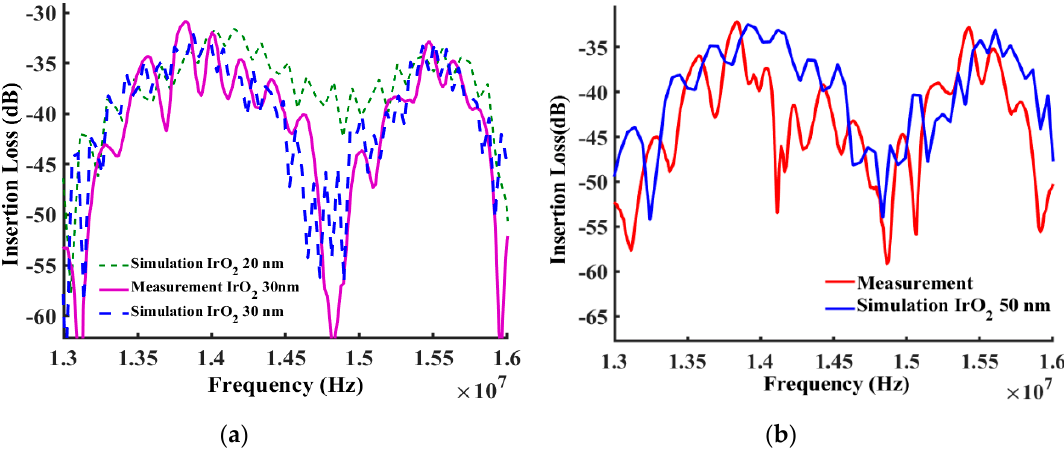
Figure 6. ( a ) Comparison between simulated and measured frequency responses for the device (with 100 nm Cr IDTs, a 500 nm-thick ZnO layer, and an IrO 2 layer of 30 nm) from 13 MHz to 16 MHz. The experimental results are obtained from the device with Cr IDTs, a 500 nm-thick ZnO layer, and a 30 nm-thick IrO 2 layers. ( b ) Comparison between simulated and measured frequency responses for the device (with 100 nm Cr IDTs, a 500 nm-thick ZnO layer and a 50 nm-thick IrO 2 layer) from 13 MHz to 16 MHz.